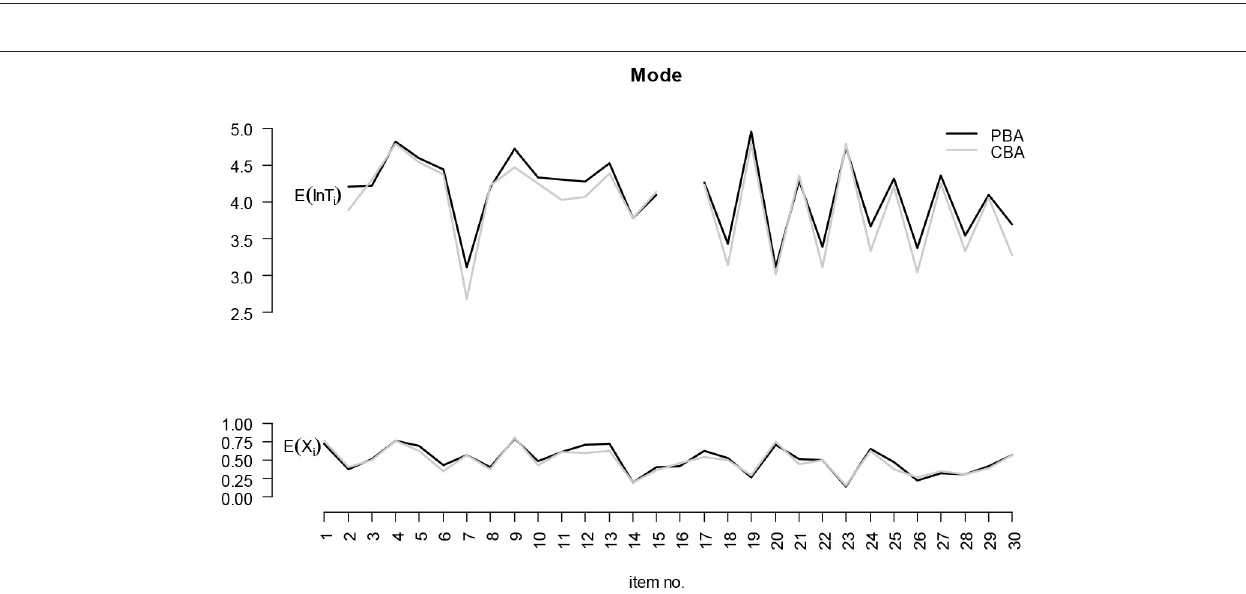
FIGURE 3 | Gender differences with respect to the log-response time and the proportion correct responses.